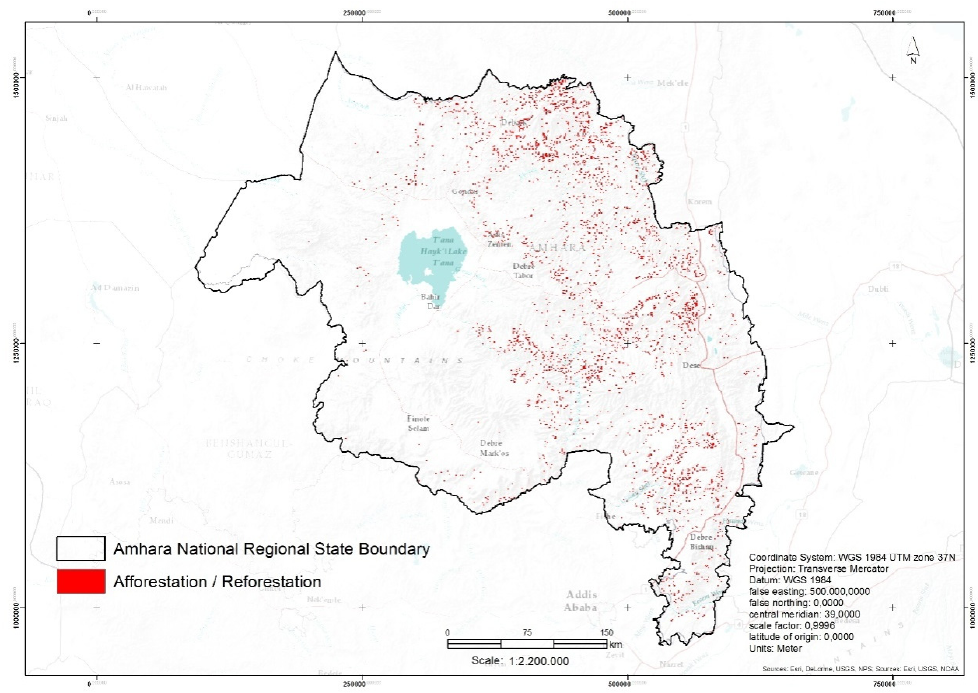
Figure 3. Opportunity areas for afforestation/reforestation.